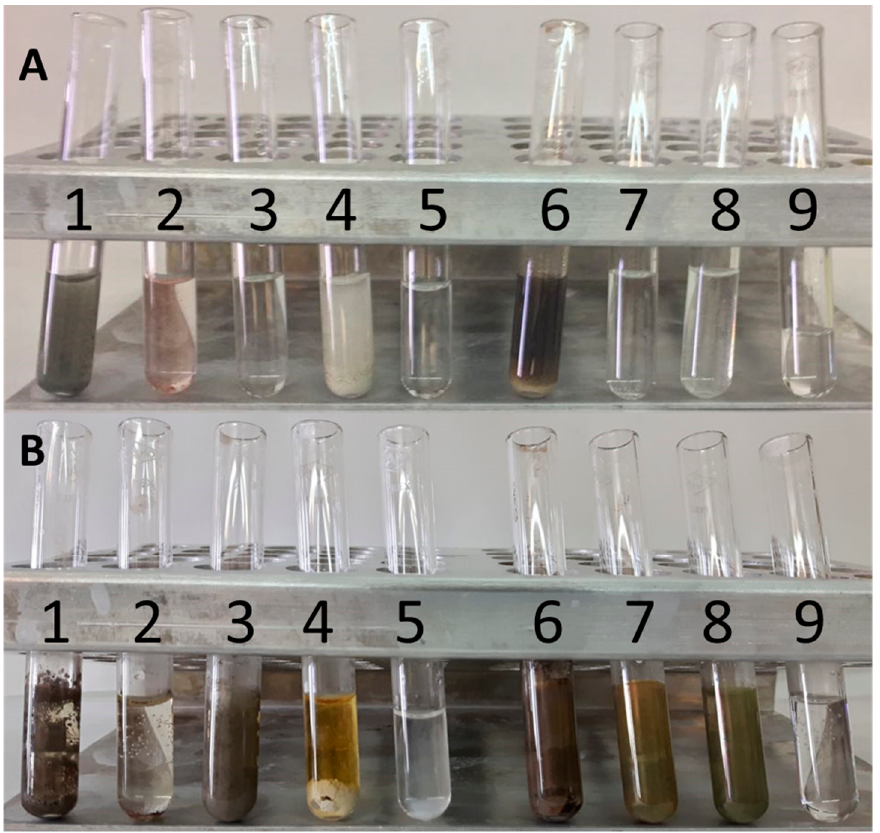
Figure 2. Colour changes after the addition of different antioxidants of plant origin to a 2 M silver nitrate solution. ( A ) inception (time 0); ( B ) after 5 h of incubation at 40 °C in the dark. The numbers identify the different antioxidants used: 1 = quercetin; 2 = β -carotene; 3 = gallic acid; 4 = ascorbic acid; 5 = hydroxybenzoic acid; 6 = caffeic acid; 7 = catechin; 8 = scopoletin; and 9 = control (no antioxidant added).